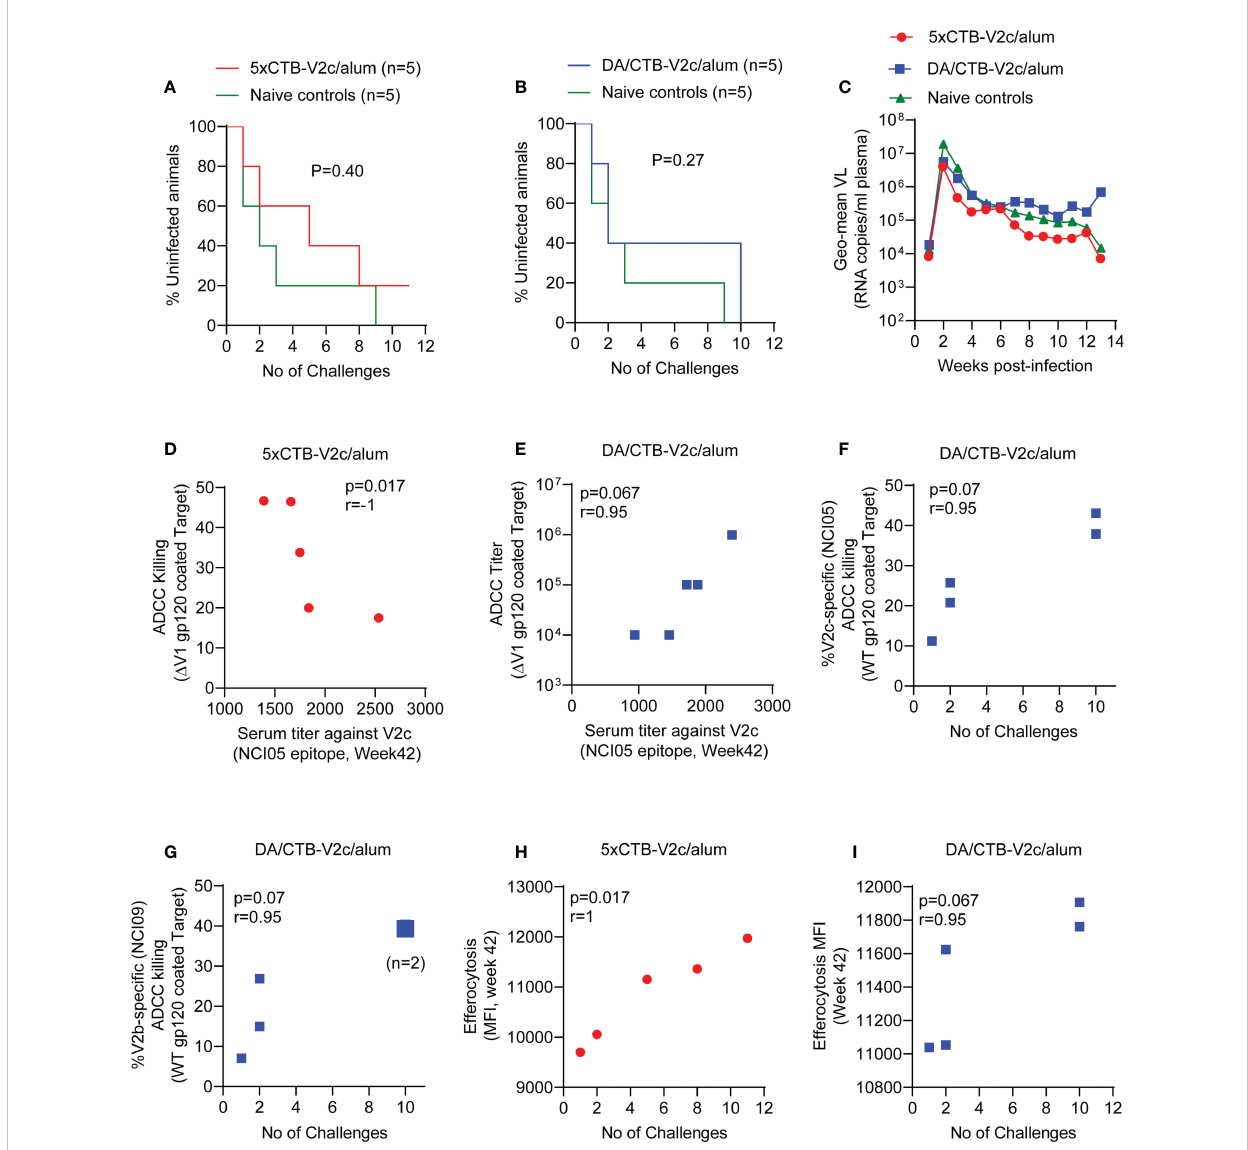
FIGURE 4 Infection rate, SIV plasma virus, and association of ADCC and efferocytosis responses with SIV acquisition. (A) Comparison of SIV acquisition in 5xCTB-V2c/alum vaccinated (n=5) and (B) DA/CTB-V2c/alum vaccinated macaques (n=5) compared to naïve control group (n=5) animals. (C) VL geometric means of all macaque groups over time. (D) Correlation of ADCC killing in the 5xCTB-V2c/alum vaccinated group and (E) ADCC titer in DA/CTB-V2c/alum vaccinated group with respective V2c speci fi c serum antibody titer. (F, G) Correlation of V2-speci fi c ADCC killing with number of rectal SIV mac251 challenges required to infect the animals in DA/CTB-V2c/alum vaccinated group. Correlation of efferocytosis MFI in (H) the 5xCTB- V2c/alum and (I) in DA/CTB-V2c/alum vaccinated group with number of intra-rectal challenges. Data shown in (A, B) were analyzed with log-rank (Mantel – Cox) test. Data shown in (D – I) were analyzed with the Spearman correlation test. Red circles indicate 5xCTB-V2c/alum vaccinated macaque group, blue squares indicate DA/CTB-V2c/alum vaccinated macaque